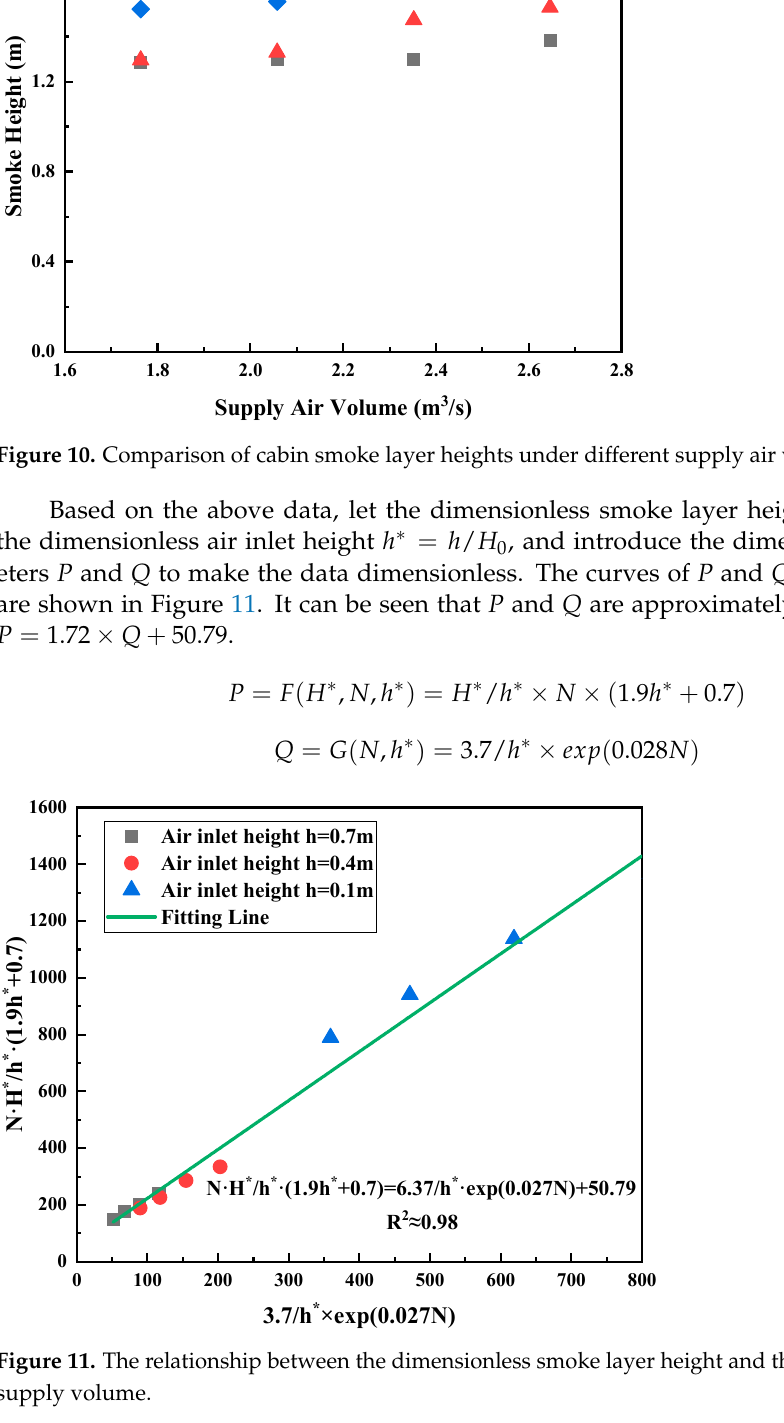
Figure 11. The relationship between the dimensionless smoke layer height and the dimensionless air supply volume.